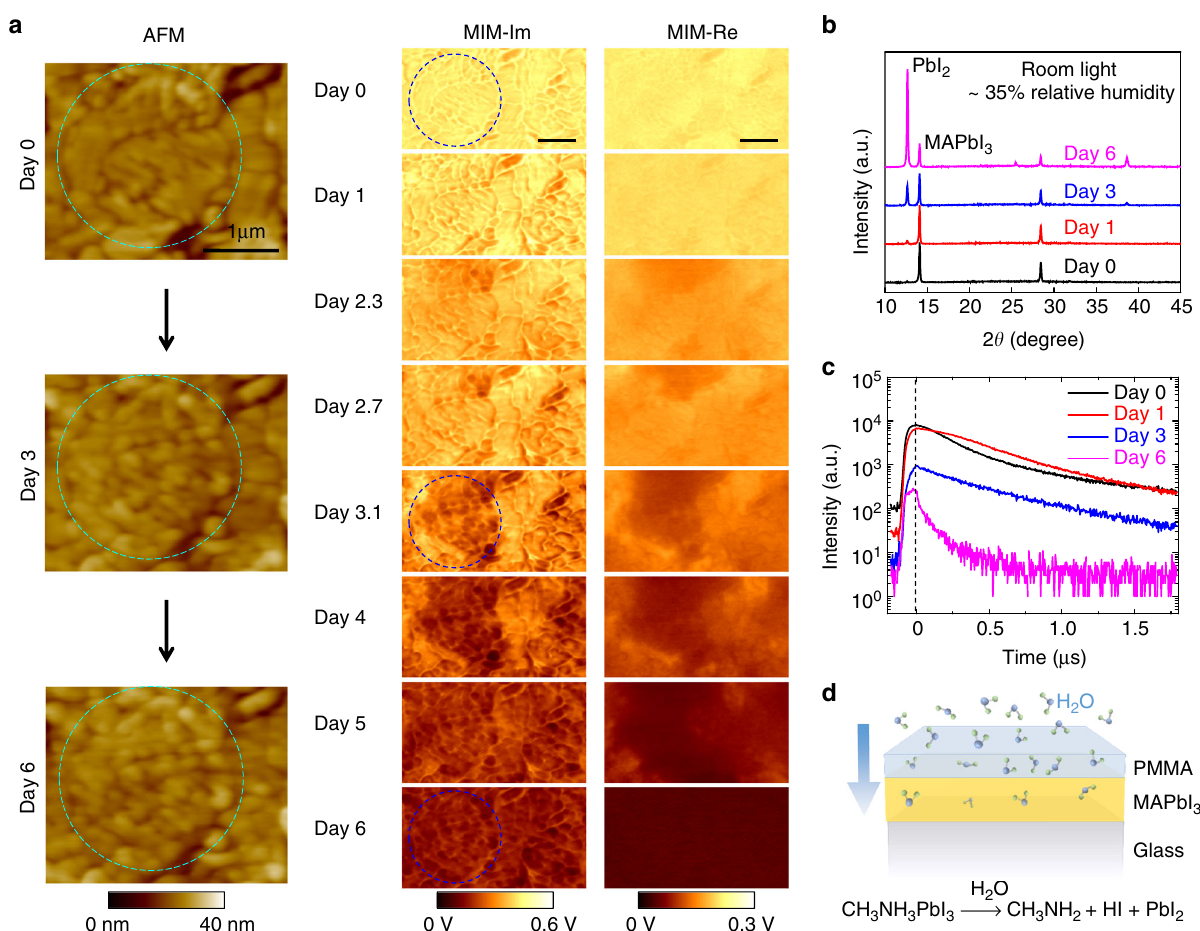
Fig. 5 Degradation process of the MAPbI 3 thin fi lm. a MIM images over 1 week with 35% relative humidity at 23 °C. Zoom-in AFM images on Days 0, 3, and 6 are shown to the left. Note that the fi ne features on large grains on Day 0 (inside dashed circles) are associated with crystal edges or terraces, which are common for polycrystalline thin fi lms. The sample was only illuminated by the 532-nm laser during the MIM imaging for about 30 min at each frame. All scale bars are 1 μ m. b Selected XRD and c TRPL data on MAPbI 3 fi lms prepared by the same method and exposed to the same conditions. The XRD peak at 2 θ = 12.66° is associated with PbI 2 . d Schematic of the aging process due to the diffusion of water molecules through the PMMA layer, which drives the decomposition of MAPbI 3 into CH 3 NH 2 and HI in the gas phase and PbI 2 in the solid